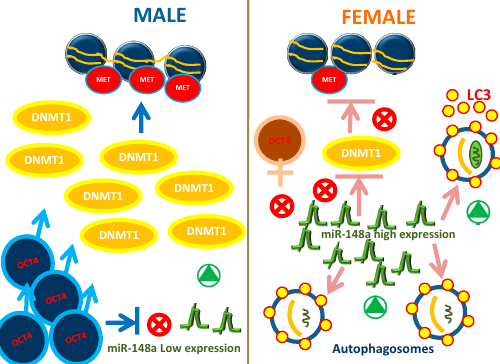
Figure 4. Gene expression networking miR-148a / DNMT1 / OCT4 / autophagy in WJ-MSCs from males compared with WJ-MSCs from females.